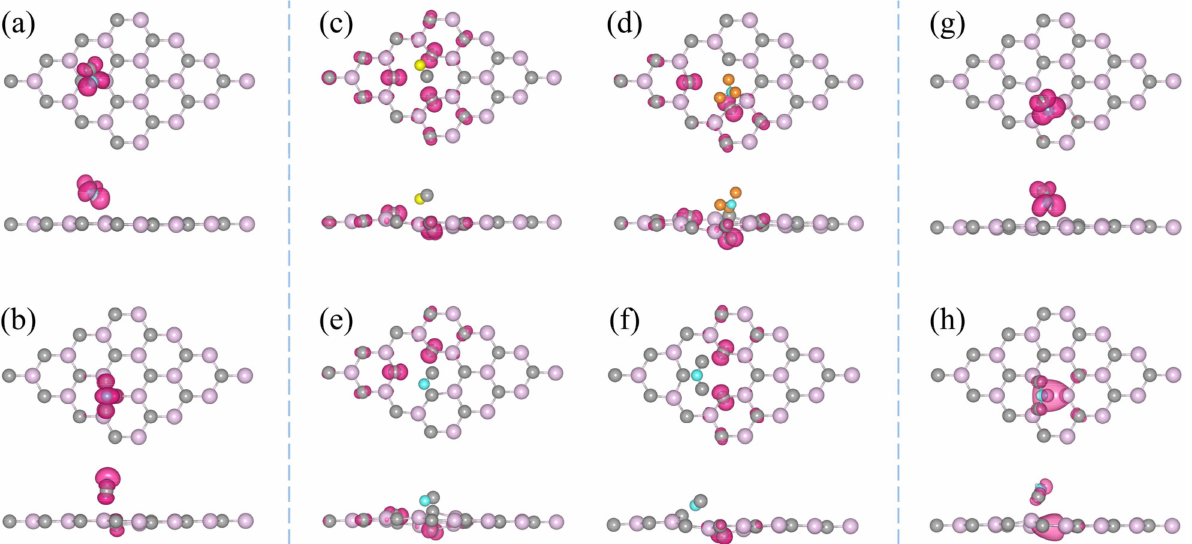
Figure 8. The spin density of ( a ) NO, or ( b ) NO 2 molecules adsorbed on intrinsic g − ZnO, of ( g , h ) V O /g − ZnO adsorption systems, and of ( c ) CO, ( d ) NH 3 , ( e ) NO, or ( f ) NO 2 molecules ad- sorbed on V Zn /g − ZnO systems. The peachy red area denotes the spin-up, whereas the white area represents the spin-down. The pink, grey, yellow, orange, and blue balls are the Zn, O, C, H, and N atoms,